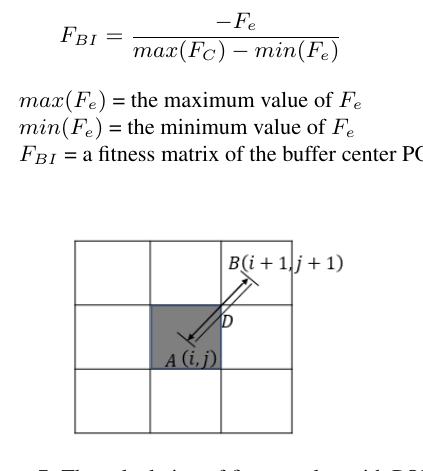
Figure 7. The calculation of fitness value with POI 4. Superpose AB with IB